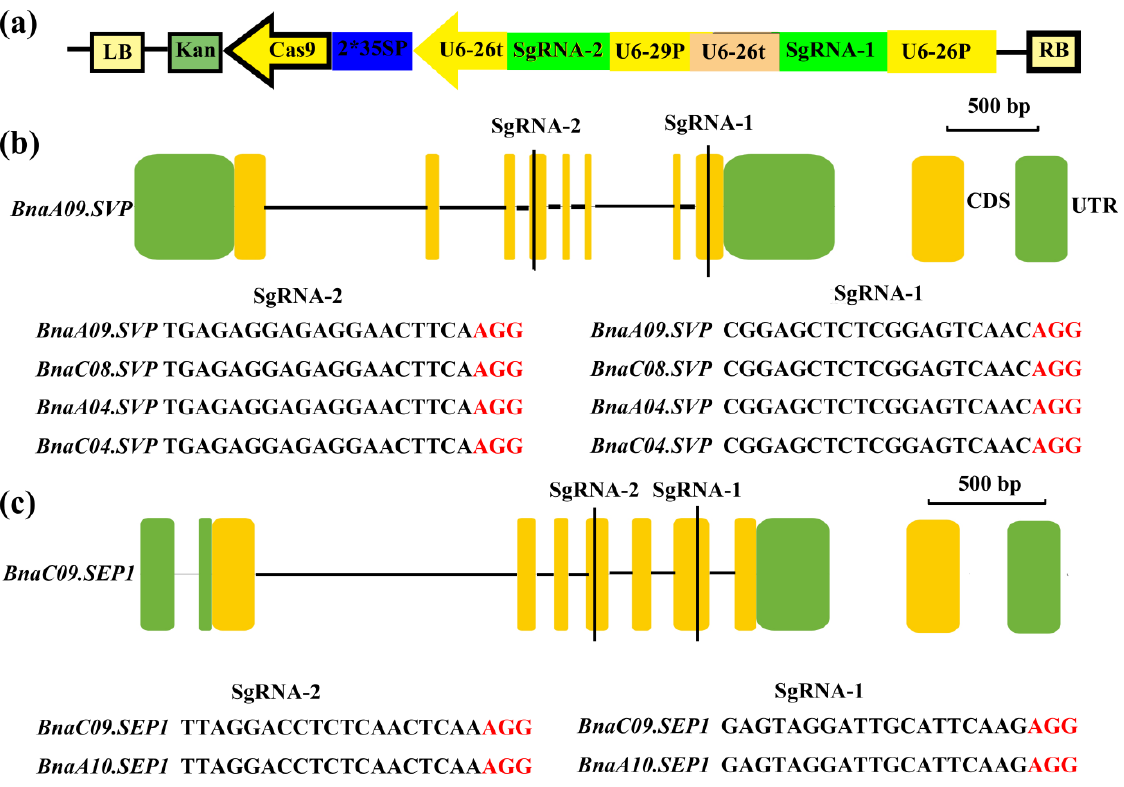
Figure 5. Schematic of BnaSVP - and BnaSEP1 -editing vectors with target sequences. ( a ) Construction of the binary plasmid vectors that house the following: a kanamycin-resistance cassette driven by 35SP; a Cas9-expression cassette driven by 35SP; and U6-26 and U6-29, which can drive two sgRNAs. ( b , c ) The single exon of BnaSVP and BnaSEP1 is shown as a yellow box and the single intron is shown as a horizontal line; the black vertical line indicates the knockout position. The target sequences are shown with the PAM sequences (red font).